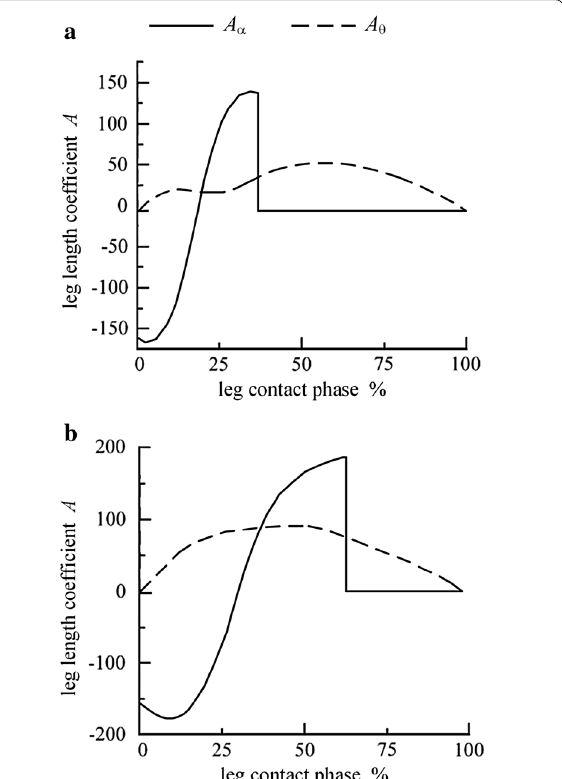
Figure 7 Trajectories of leg length coefficients: a horizontal speed is 7 m/s, and b horizontal speed is 10